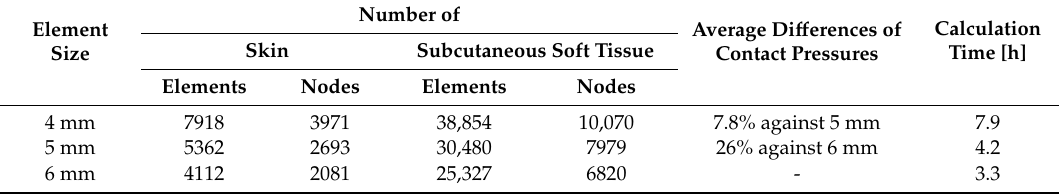
Table 4. Numbers of elements and nodes for three models used in mesh sensitivity study, average di ff erences of contact pressures from the model with larger mesh size on the regions that were important for evaluating gripping comfort, and calculation times required for a grasping